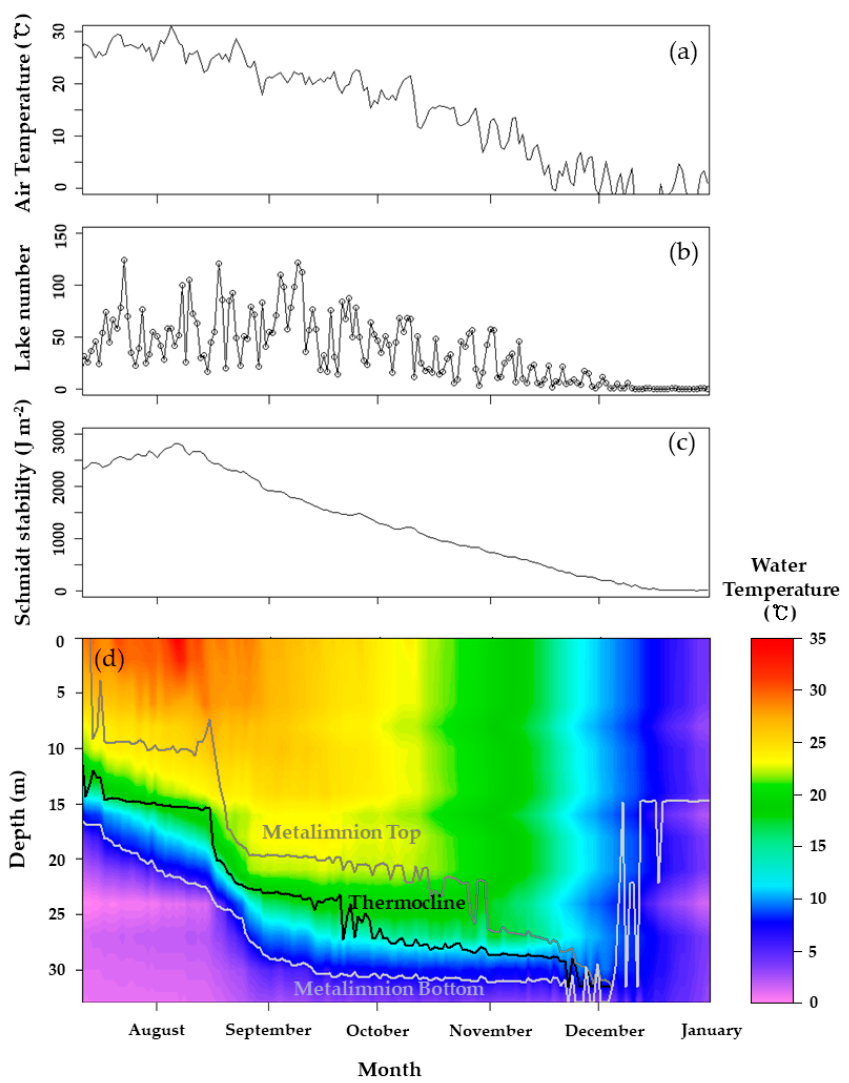
Figure 3. Temporal variations of ( a ) air temperature, ( b ) Lake number (LN), ( c ) Schmidt stability (S t ), and ( d ) time–depth profile of water temperature.